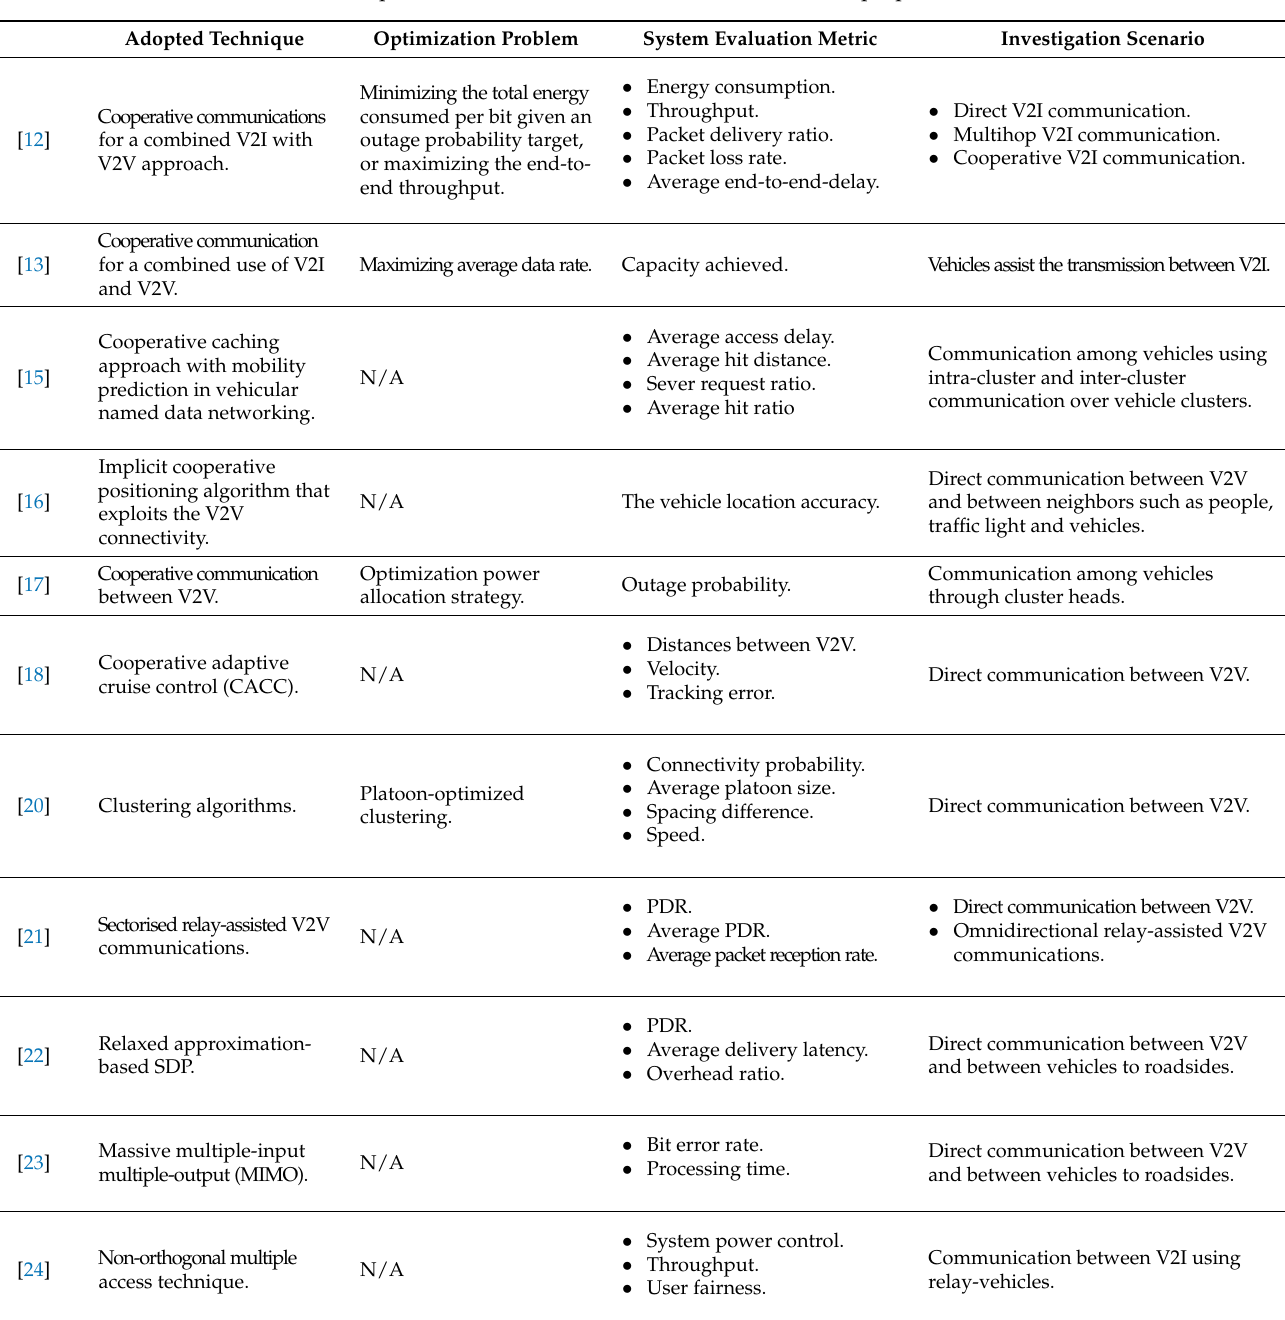
Table 1. Comparison between different related works and the proposed